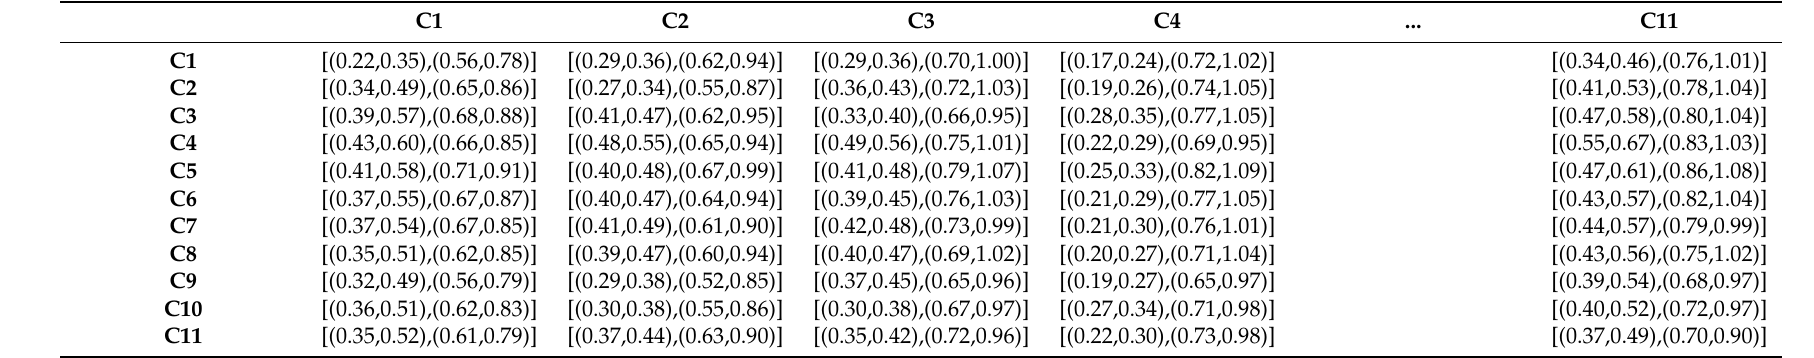
Table 6. The total relationship matrix of the conditioning